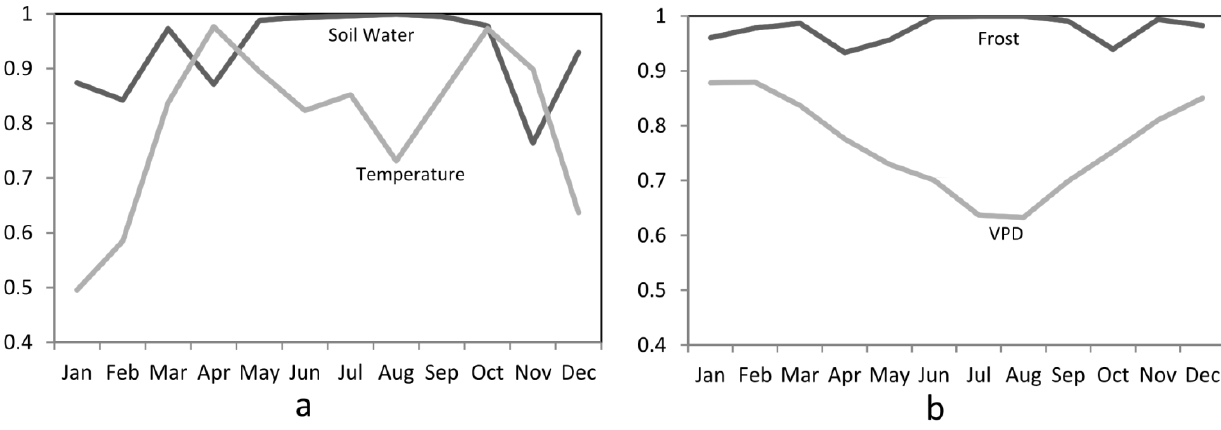
Figure 4. Climatic modifiers in a monthly time-step; ( a ) Soil water and temperature, ( b ) frost and